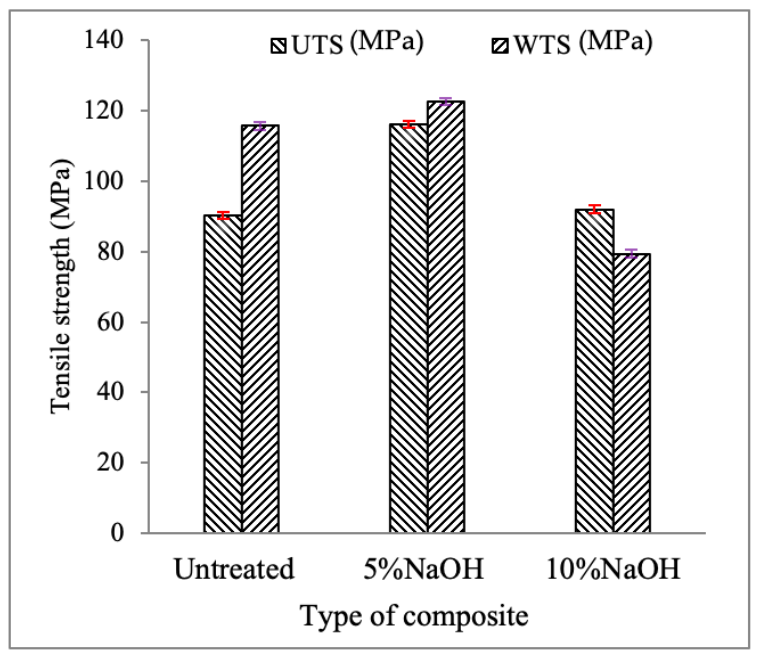
Figure 4. Tensile strength plot of unidirectional (UTS) and woven (WTS) composites.